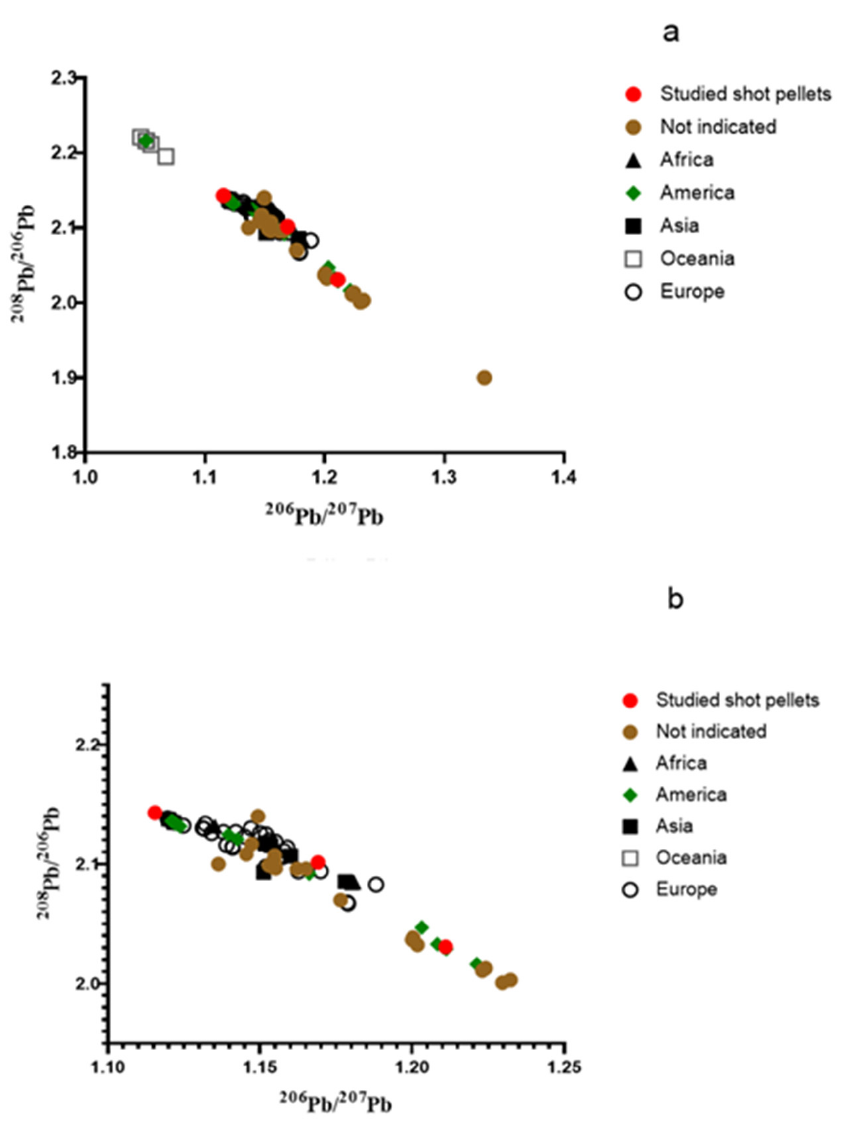
Figure 2. ( a ) Scatter plot for 208 Pb/ 206 Pb versus 206Pb / 207 Pb of lead isotope ratios for different shot pellet and ammunition manufacturers and studied soils. “Not indicated” means that authors have not reported a probable origin of shot pellet manufacturer/brand. ( b ) Detail of the crowded central region. Data compiled from [5,16–22,26,33,34,39,41–45].